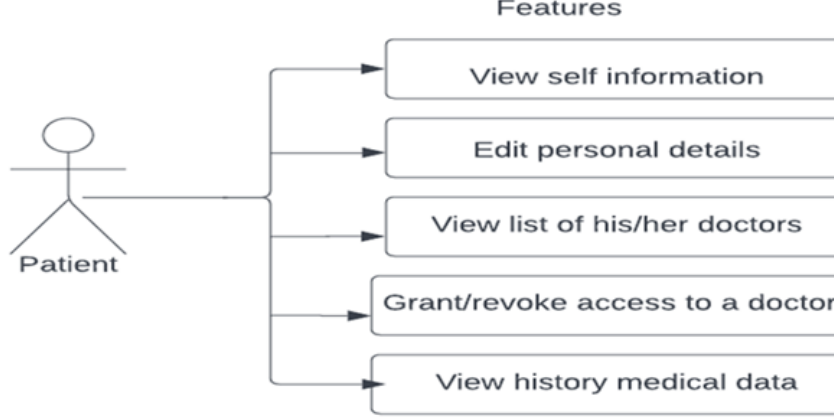
Figure 5. Illustration of the patient persona.